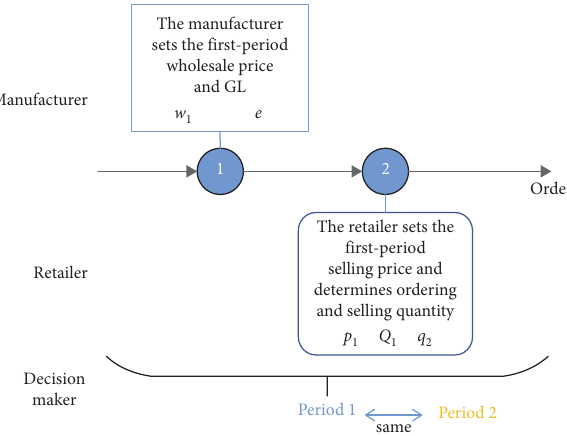
Figure 2: Decision process when the retailer does not hold strategic